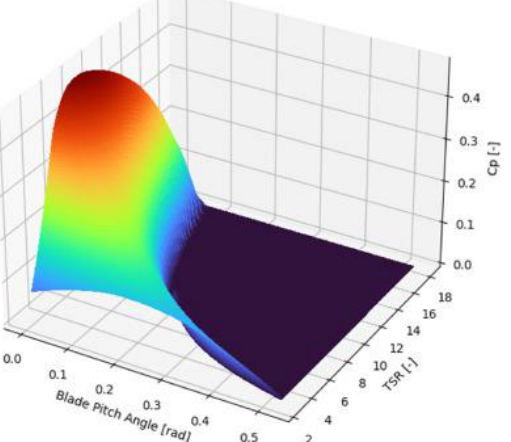
Figure 1. Variation of the power coefficient with the pitch angle and the TSR for the NREL 5 MW wind turbine [39].